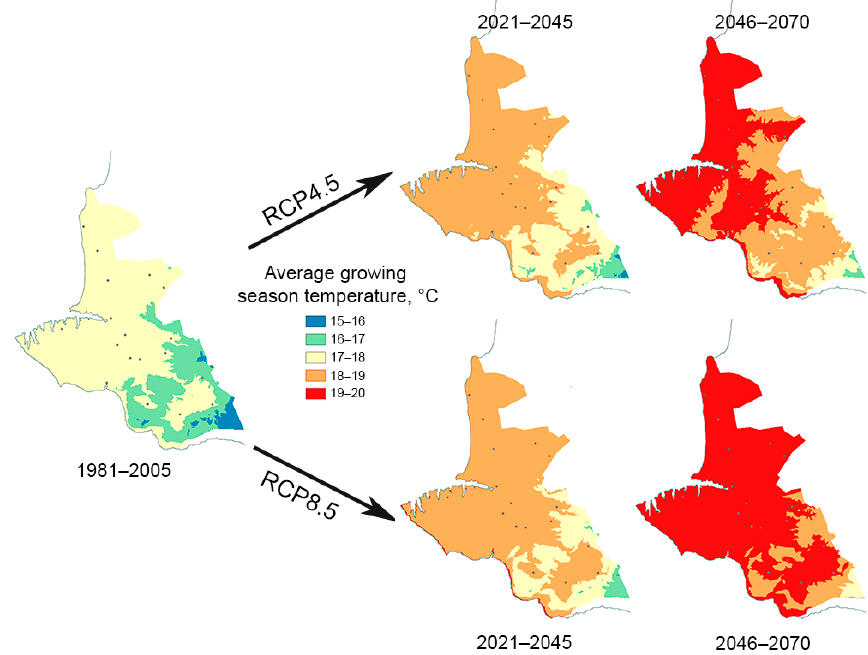
Figure 2. Spatial distribution of the average growing season temperature (°C) over the Sevastopol region obtained by the ensemble of RCMs for the base (1981–2005) and two future periods (2021–2045 and 2046–2070).